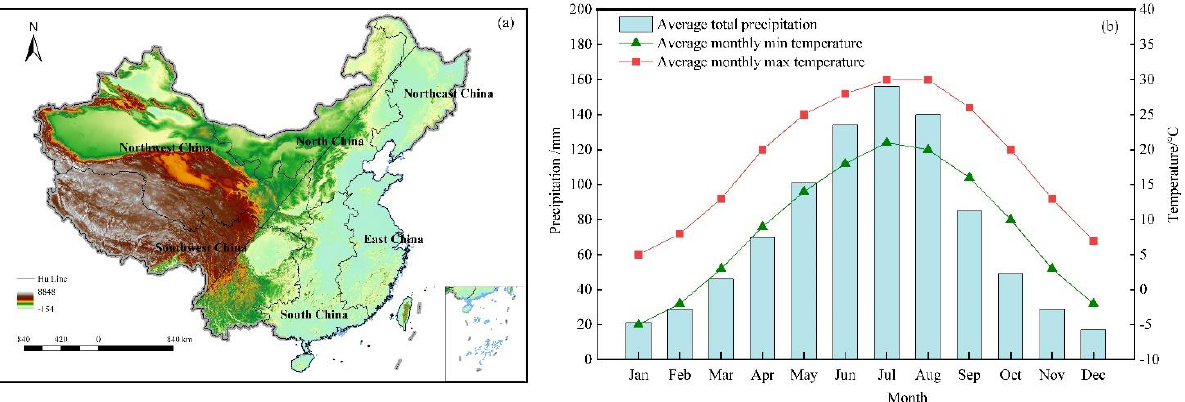
Figure 1. Maps of the ( a ) topographic features and ( b ) average rainfall and temperature in